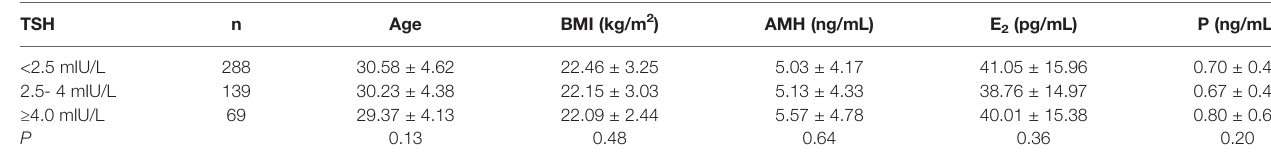
TABLE 1 | Comparison of general conditions of patients with different TSH levels.